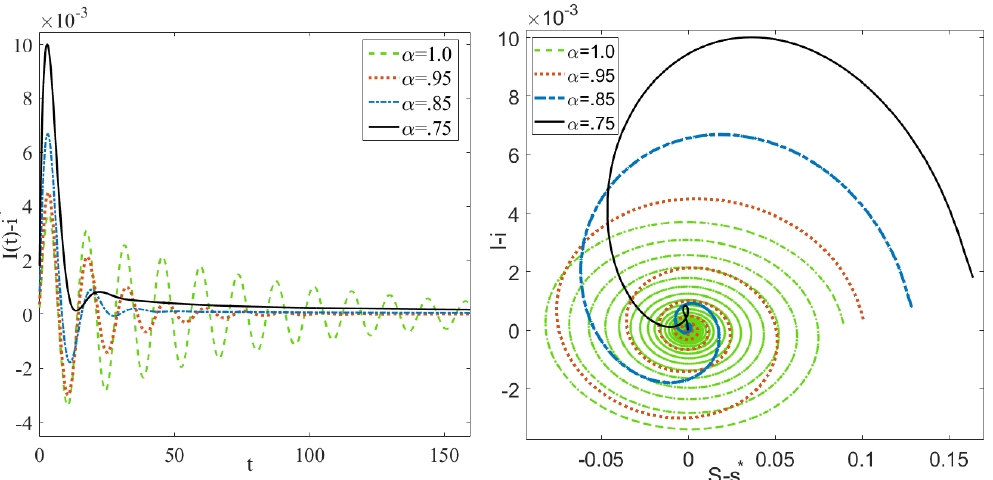
Figure 4. Simulations of solutions of the SEIR FDE centered about the endemic equilibrium (EE) for α = 1, 0.95, 0.85, and 0.75 using Equation (18) shows a suppression of damped oscillations as α decreases. The simulations are done using µ (cid:63) = 0.0027, β (cid:63) = 119.2257, δ (cid:63) = 16.7301, and σ (cid:63) = 10.1873. The models were fitted to three measles epidemics in the pre-vaccination era in three different cities: New York, London, and Portsmouth. Simulations of the fitted ODE and FDE models are shown in Figure 5. See Appendix B for the data and the parameter estimates, as